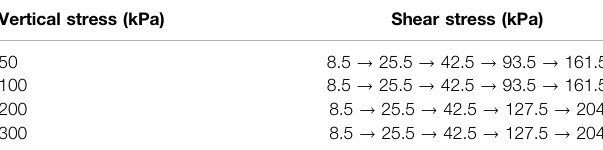
TABLE 3 | Scheme of direct shear test.